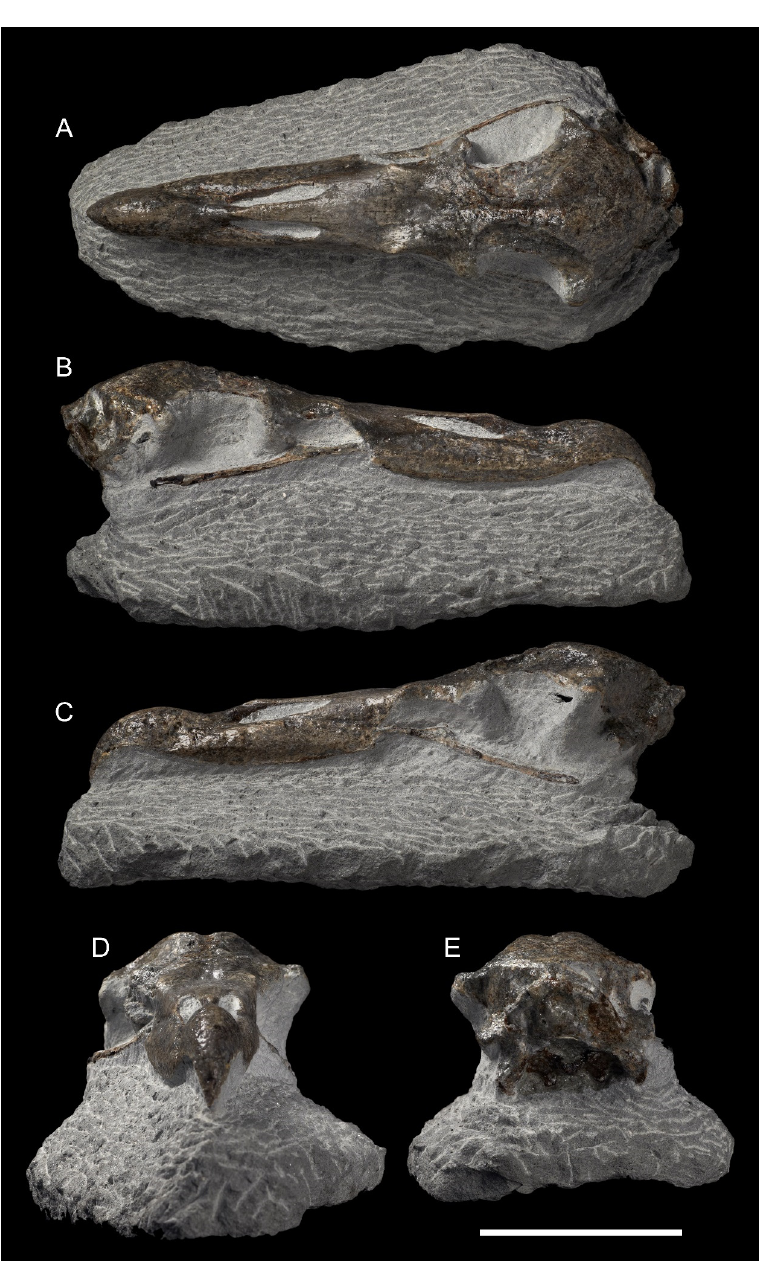
Figure 1. Skull (holotype, NMNZ S.048502) of Macronectes tinae sp. nov., partially embedded in matrix, in different views; scale bar = 5 cm. ( A ) Dorsal view. ( B ) Lateral view (right). ( C ) Lateral view (left). ( D ) Anterior view. ( E ) Caudal view.